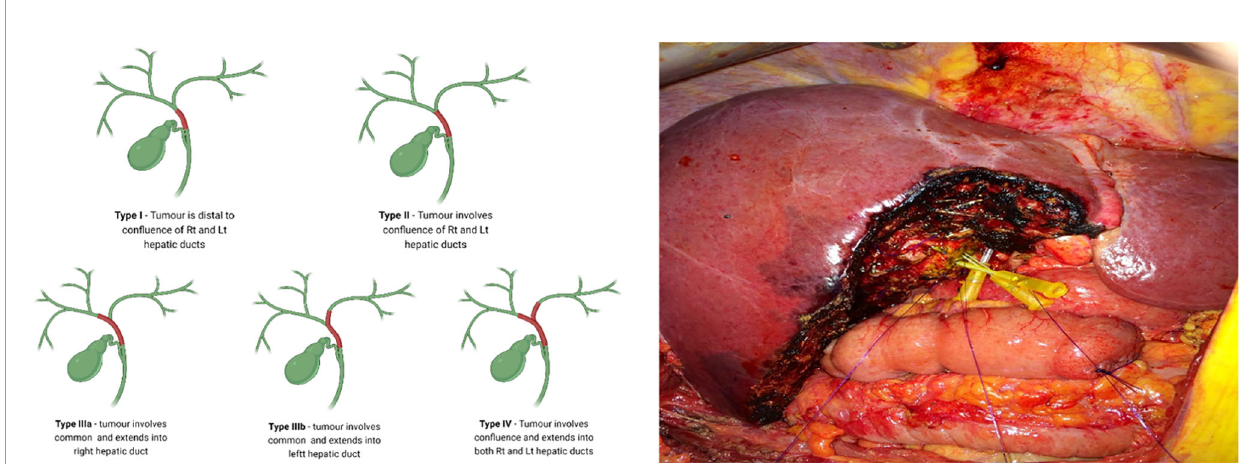
FIGURE 1 | Surgical resection of perihilar CCA is guided by the Bismuth-Corlette classi fi cation with types II-IV (Left) requiring extensive surgery, which involves major hepatic resection in the form of extended hepatectomy and caudate lobectomy (Right). (Right) - central hepatic and biliary con fl uence resection for a Bismuth- Corlette type II hilar CCA. Right anterior, right posterior and Left hepatic ducts are